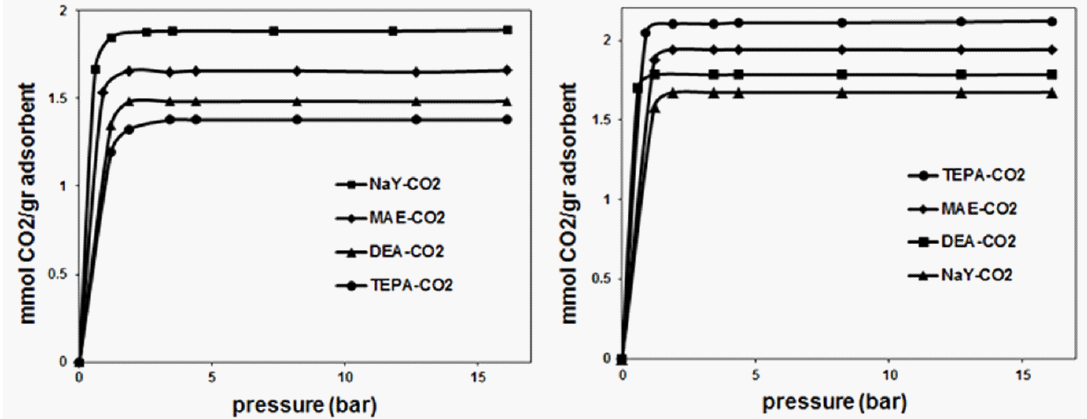
Fig. 7. Adsorption isotherms of CO 2 in pristine and modified zeolites at 298 K (a) and 348 K (b)